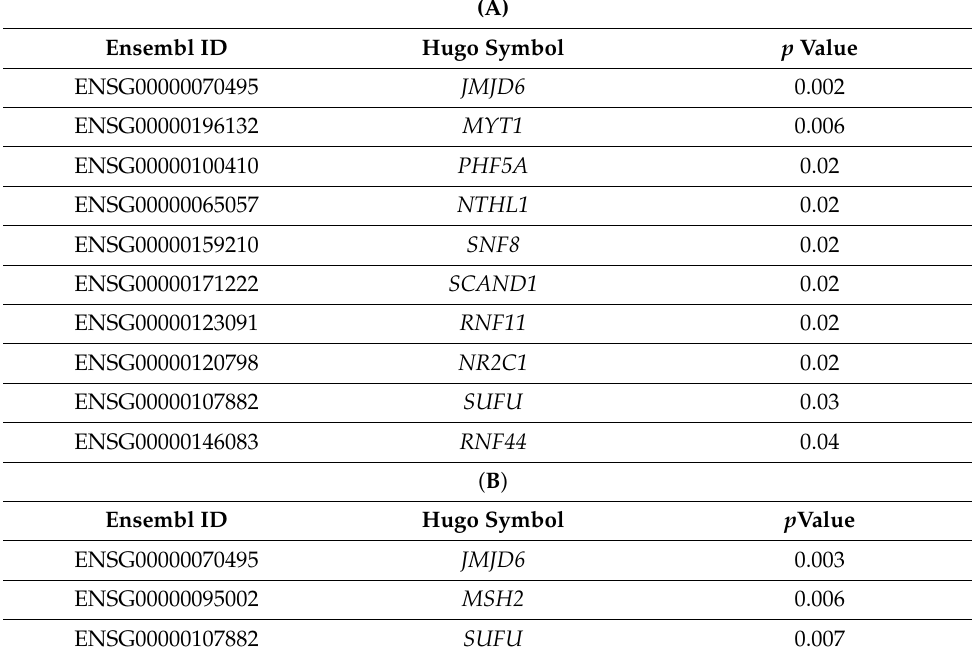
Table 2. Univariate cox regression analysis for regulons enrichment. Top ten genes are listed for the ( A ) UTA and ( B ) EMC